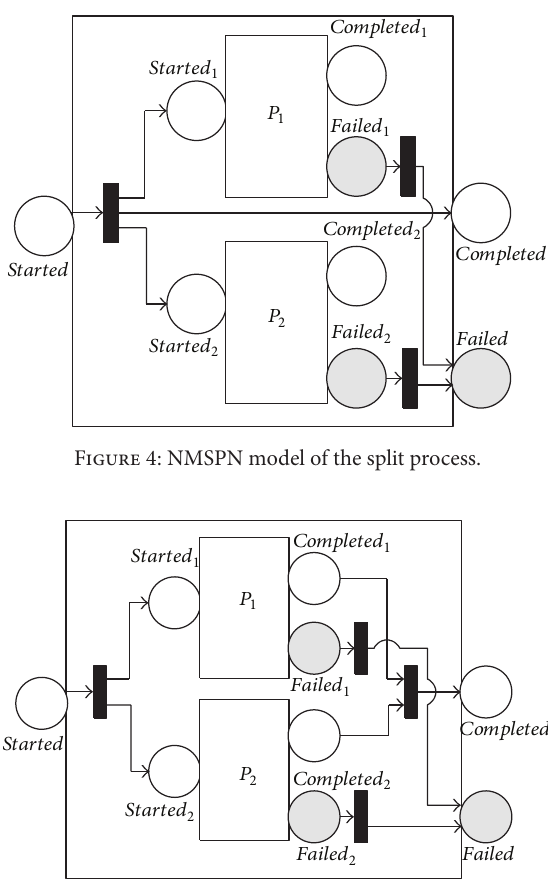
Figure 5: NMSPN model of the split-join